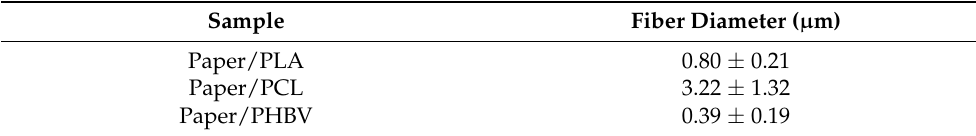
Table 4. Fiber diameter of PLA, PCL and PHBV electrospun coatings on